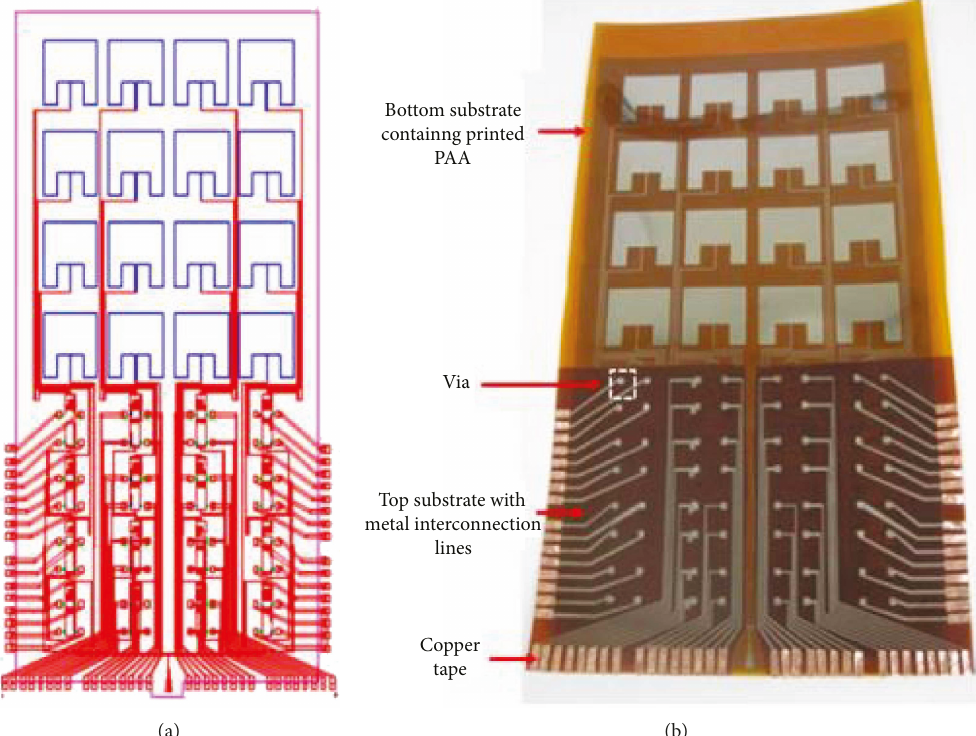
Figure 3: (a) Schematic layout of a 4 by 4 PAA subsystem with a multilayer interconnection scheme. (b) Photograph of the fully printed PAA system